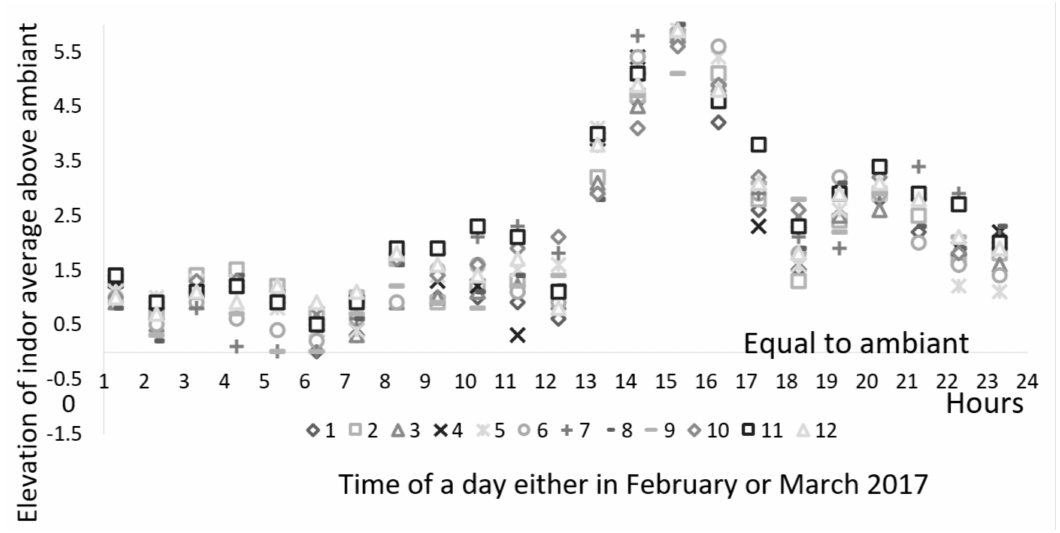
Figure 2. Elevation of indoor air temperature average well above ambient levels in 12 typical building indoors shows environmental heat stress on façades /